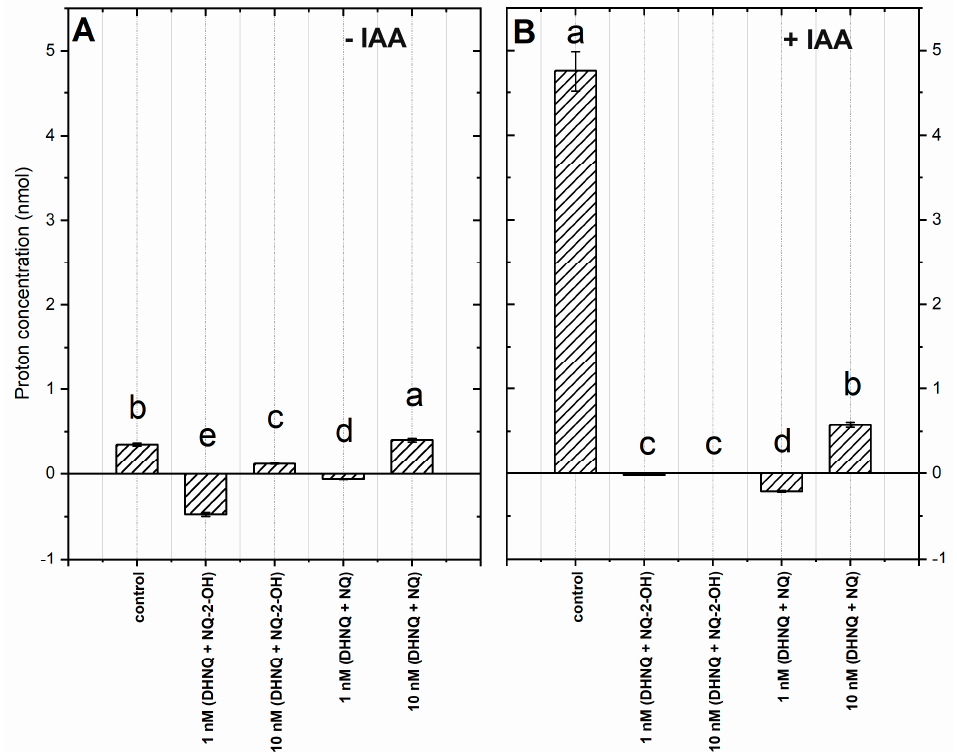
Figure 3. The effect of DHNQ combined with NQ-2-OH or NQ on the proton extrusion of the maize coleoptile segments that were incubated ( A ) without and ( B ) with IAA. The presented data show the differences between the H + concentration per coleoptile segment at 600 and 120 min and are the mean of six independent experiments. Mean values that are followed by the same letter within a group were not significantly different from each other. Bars indicate the means ± SEs.